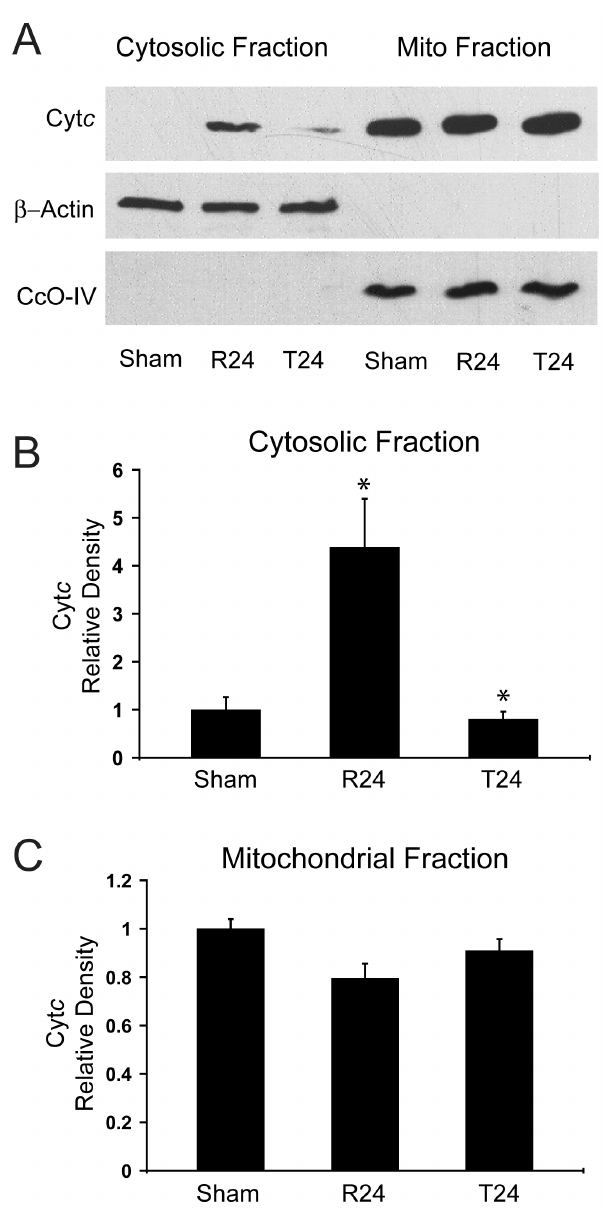
Figure 1. Cytochrome c release is inhibited by insulin administration. (A) Sham operated control animals (Sham, n=3) show faint detectable amounts of Cyt c in the cytosolic fraction of hippocampal CA1 neurons. After 8 min of ischemia followed by 24 h of reperfusion (R24, n=5) cytosolic Cyt c increases , 4 fold (p , 0.05) and there is a trend toward mitochondrial Cyt c decrease (p=0.08), both indicative of mitochondrial Cyt c release. Animals exposed to 8 min of ischemia followed by 24 h of reperfusion with a single bolus of IV insulin at the onset of reperfusion (T24, n=5) demonstrate a reduction of cytosolic Cyt c (p , 0.05) and increased mitochondrial Cyt c compared to the R24 controls. (B and C) Densitometric analyses of Western blot data (Mean + / 2 SEM, *p ,